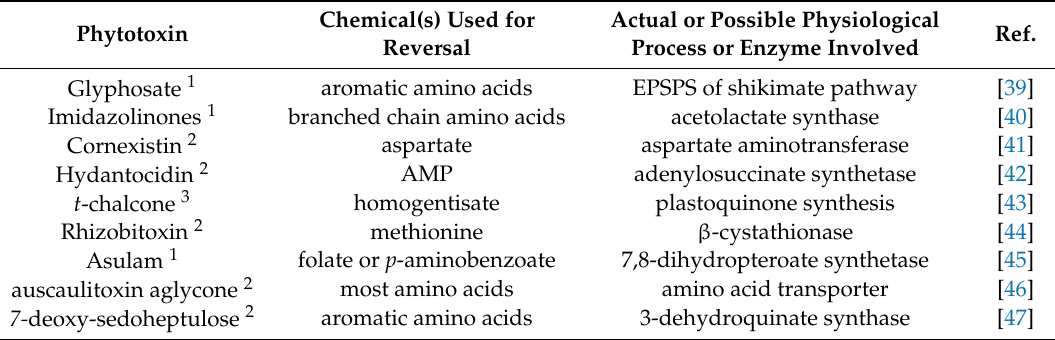
Table 1. Examples of reversion of e ff ects of both phytotoxic phytotoxins (PPs) and other phytotoxins. Chemical(s) Used for Actual or Possible Physiological Phytotoxin Reversal Process or Enzyme Involved